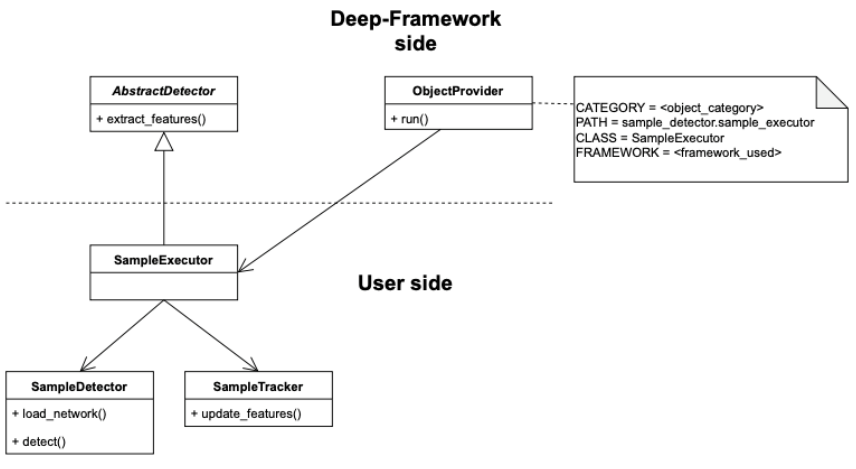
Figure 5. Detector class diagram showing the relation between the Deep-Framework classes and the user-defined classes related to the Detector component. More details are provided in Appendix A.1.